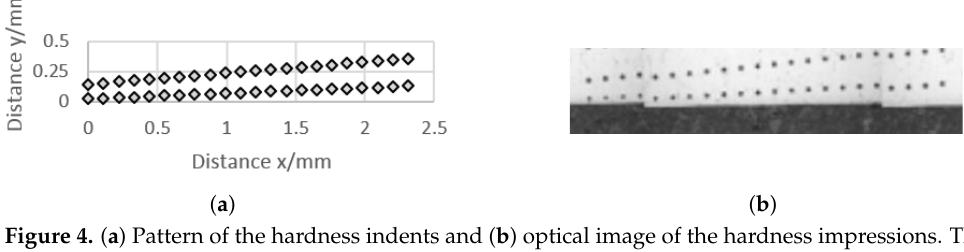
Figure 4. ( a ) Pattern of the hardness indents and ( b ) optical image of the hardness impressions. The distance in the X-direction was 110µm and in the case of the samples plasma nitrided at 560°C 150µm. The value 110µm corresponds to 3 times the diameter of a hardness of approximately 690HV0.5, and 150µm corresponds to 3 times the diameter of a hardness of approximately 371HV0.5. The value of 550HV0.5 was assumed to be the minimum hardness that could occur. The first indent was set at a distance of approximately 25µm. From the 1st to the 21st indent (125µm), the distance in the Y-direction was 5µm. From the 22nd hardness indent on, the distance in the Y-direction was set to